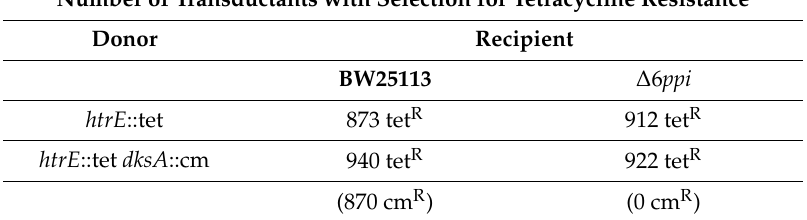
Table 4. The essentiality of the dksA gene in ∆ 6 ppi as determined by the linked htrE mutation. Number of Transductants with Selection for Tetracycline